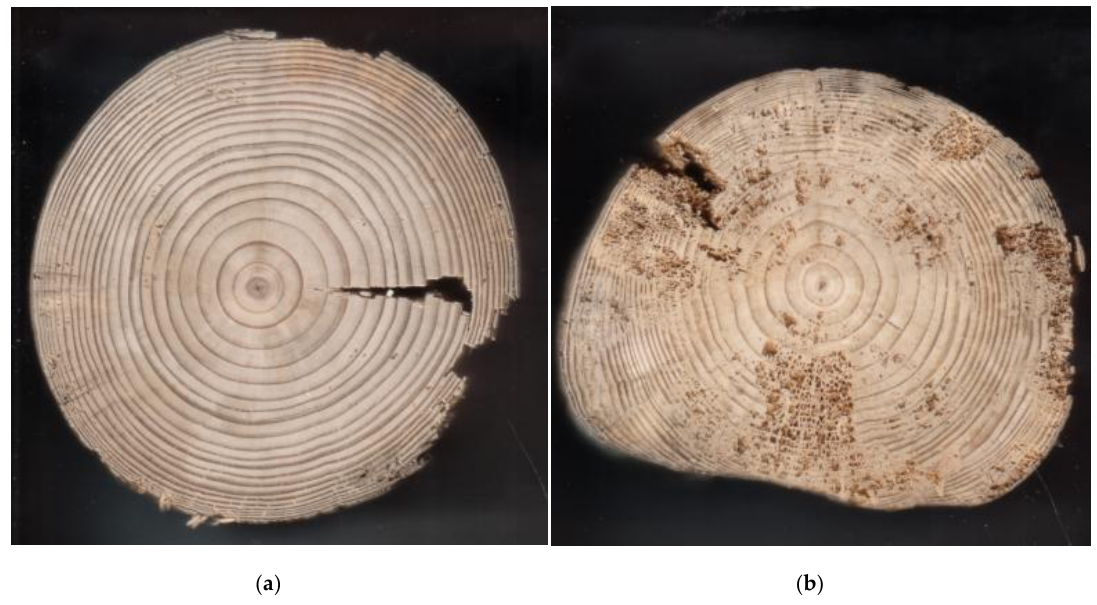
Figure 3. Full cross-sections of spruce wood samples taken from the forest road in section SW of Czereszenka Forest District in the Stuposiany Forest Subdistrict: ( a ) sample no. Sw2-SW, ( b ) sample no. Sw6-SW.